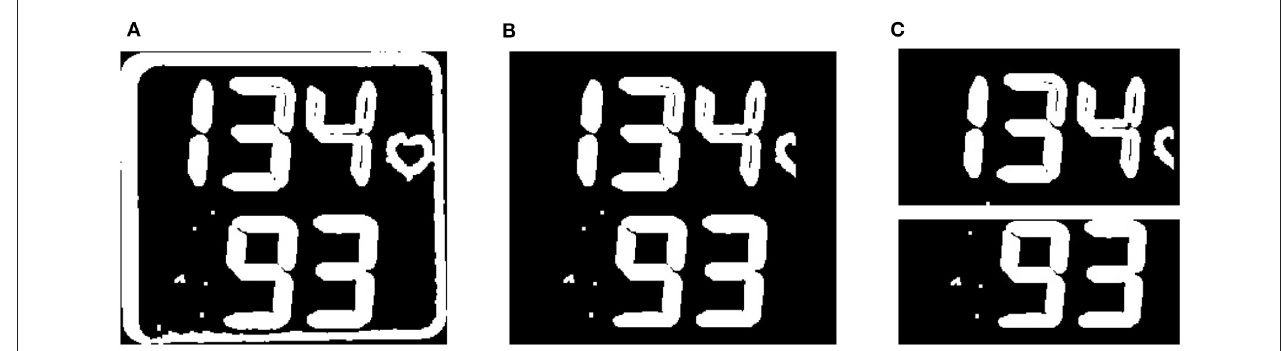
FIGURE 7 | Liquid crystal display (LCD) frame normalization. (A) The binary thresholded blood pressure (BP) LCD frame extracted with contour border is shown, and (B) the LCD frame after border removal is shown. (C) 2 single monitor LCD frames as a final result of the LCD normalization module are shown (see section